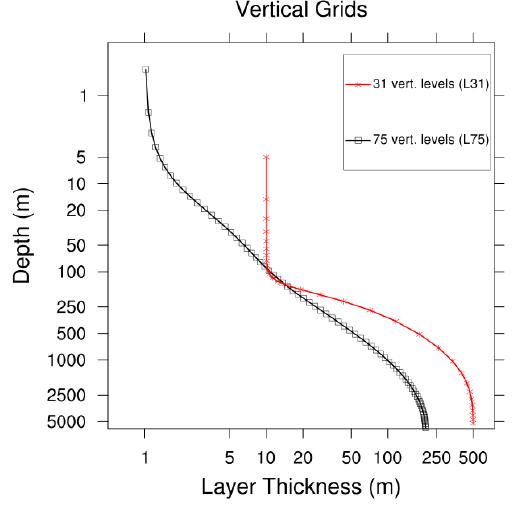
Figure 1. Thickness of vertical levels as a function of depth for two vertical grids: L31 (red) and L75 (black). Each plotting point (squares and stars) corresponds to the depth of